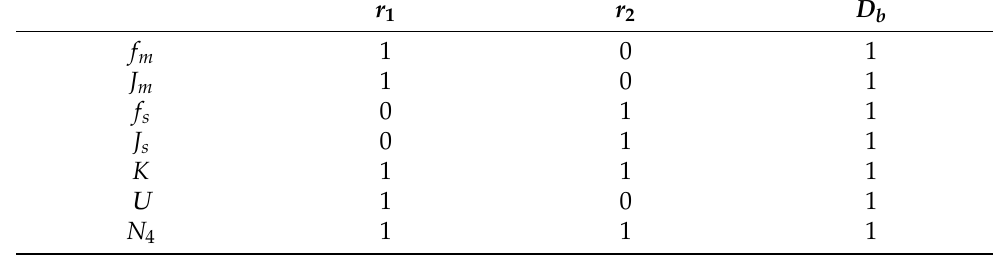
Table 2. Fault signature matrix.